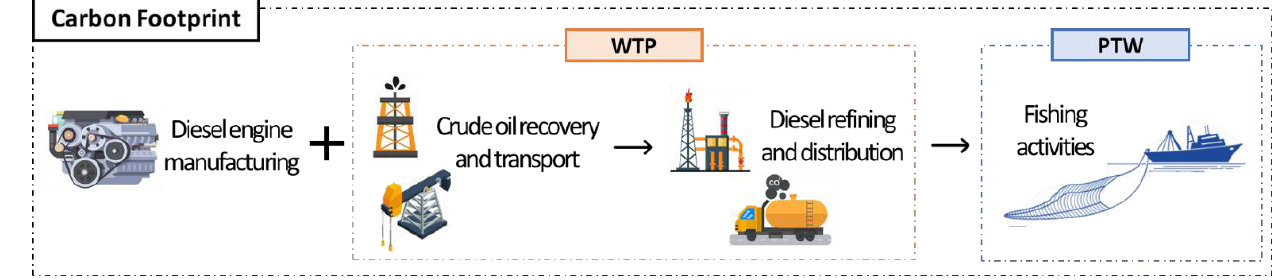
Figure 4. The LCA of a diesel-powered trawler.